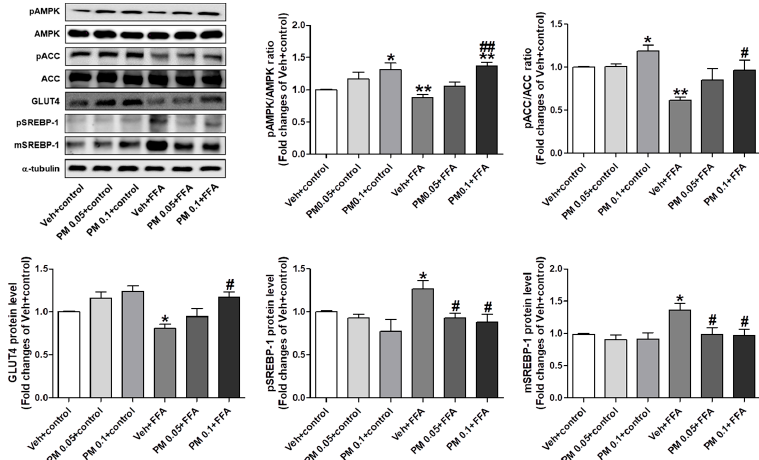
Figure 3. The effect of PM extract on the adenosine monophosphate-activated kinase (AMPK) and acetyl-CoA carboxylase (ACC) phosphorylation, glucose transporter 4 (GLUT4), and sterol regulatory element-binding protein-1 (SREBP-1) protein levels in FFA-treated HepG2 cells. Representative images of western blot analysis were from three independent experiments, and the densitometric quantification of relative band intensities are presented. The cells were treated with 1 mM of FFA for 24 h, and then were harvested. PM was pretreated 1 h prior to FFA treatment at the indicated concentrations, and control cells were treated with 1% of fatty acid-free BSA. Data are the mean ± SEM. * p < 0.05 and ** p < 0.01 vs. Veh + control group; # p < 0.05 and ## p < 0.01 vs. Veh + FFA group.